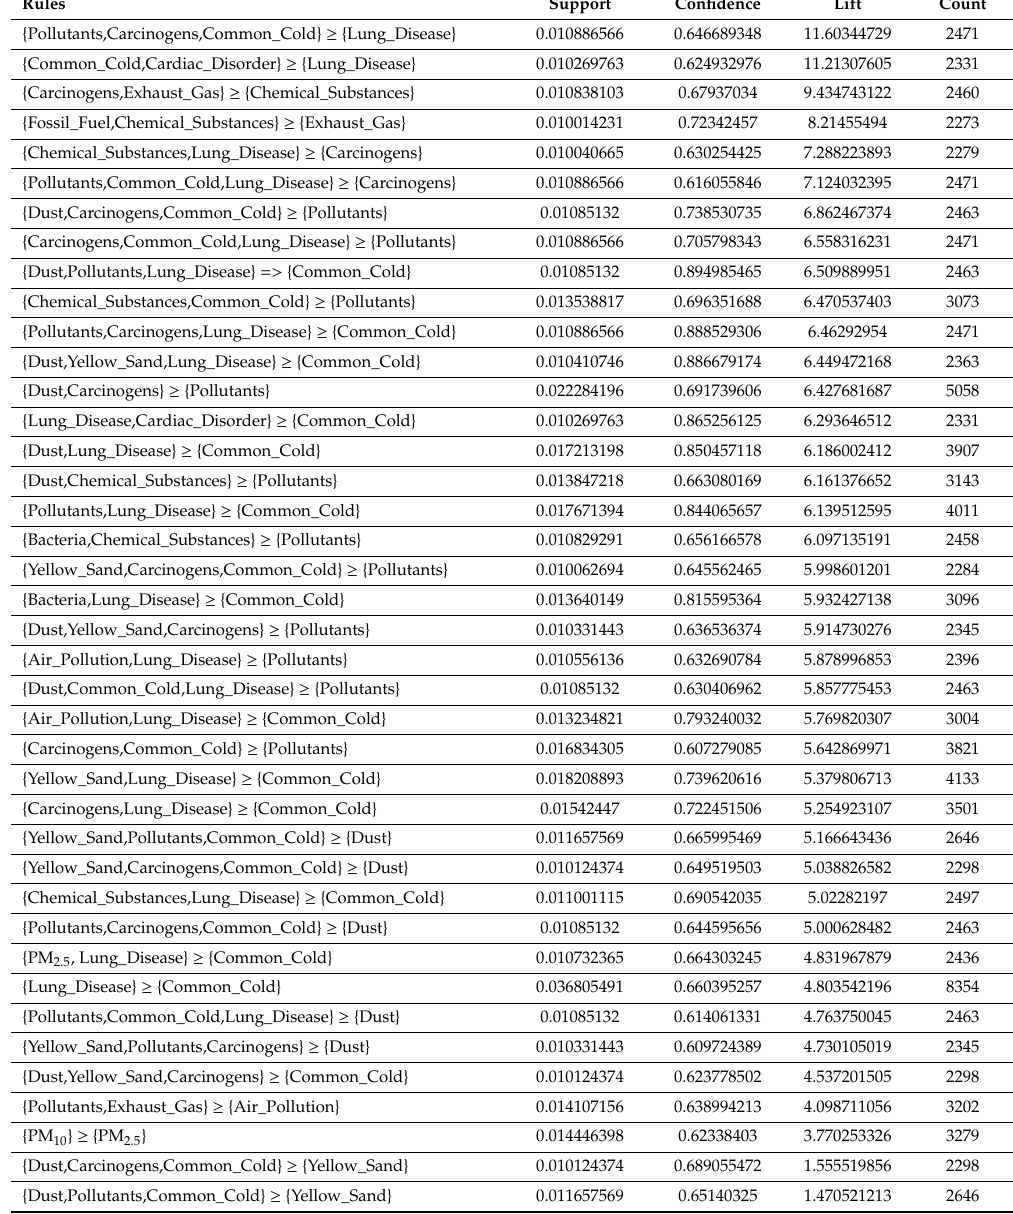
Table 2. Association Rule between Cause-and-Disease